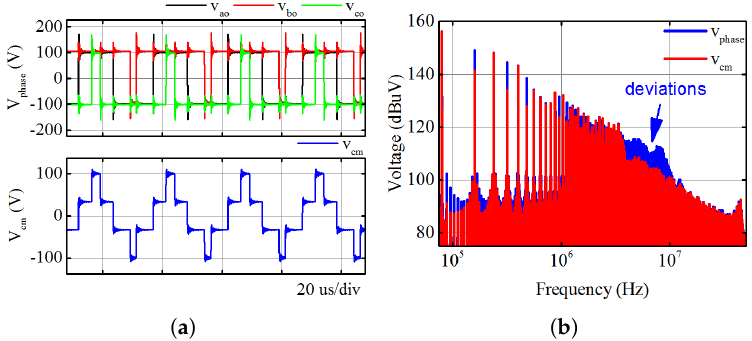
Figure 22. Comparison between calculated v phase and v cm : ( a ) Time-domain waveforms, ( b ) Spectra.